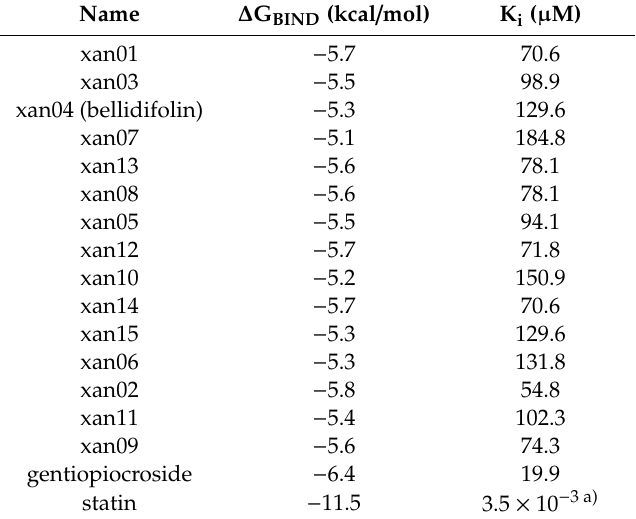
Table 4. Summary of all compounds used in the HMGR molecular docking calculations with their binding energies ( ∆ G BIND ) and inhibition constants (K i ).